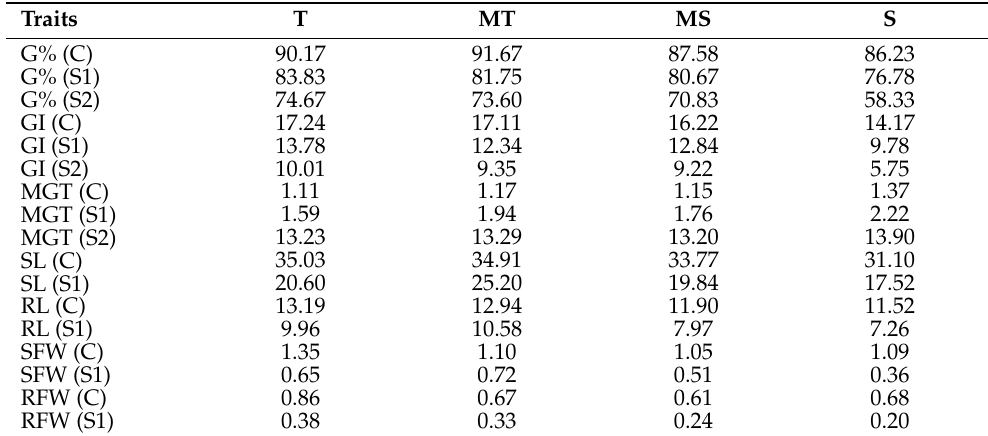
Table 9. Mean values of different germination and seedling traits measured under different salt concentrations of the four categories of salt tolerance of